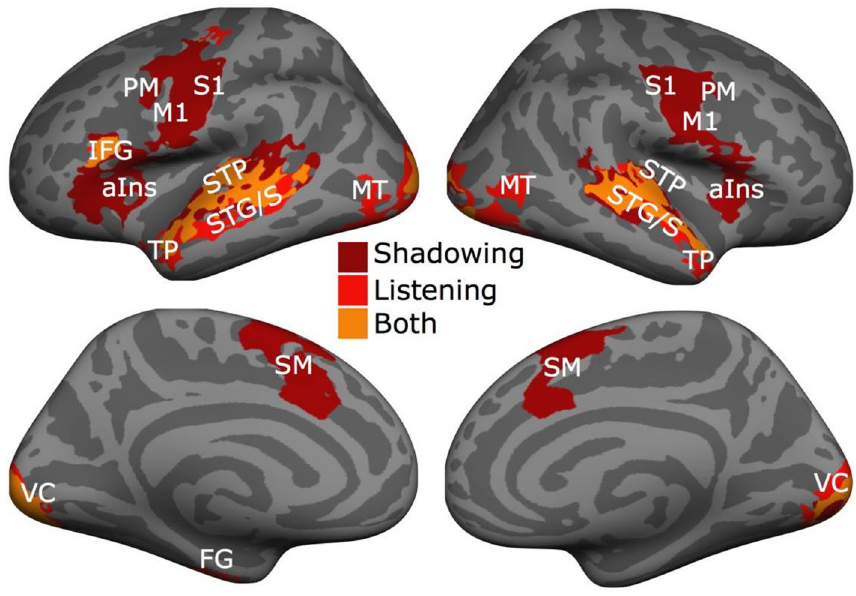
Figure 3. The listening task and the shadowing task activated partly overlapping regions in distributed cortical networks. Significant clusters (initial cluster threshold z = 3.1; permutated cluster significance p < 0.05, family- wise error rate, FWER corrected across all whole brain analyses) for the listening task vs. silent baseline (Bright red and orange), and the shadowing task vs. silent baseline (dark red and orange). Upper row: Lateral views of the inflated left and right hemisphere (lighter gray denotes gyri and darker gray sulci). Lower row: Medial views of the left and right hemisphere. STP supratemporal plane, STG/S superior temporal gyrus/sulcus, TP temporal pole, MT middle temporal visual area, aIns anterior insula, IGG inferior frontal gyrus, M1 primary motor cortex, PM premotor cortex, S1 primary somatosensory cortex, VC visual cortex, FG fusiform gyrus, SM supplementary motor cortex.